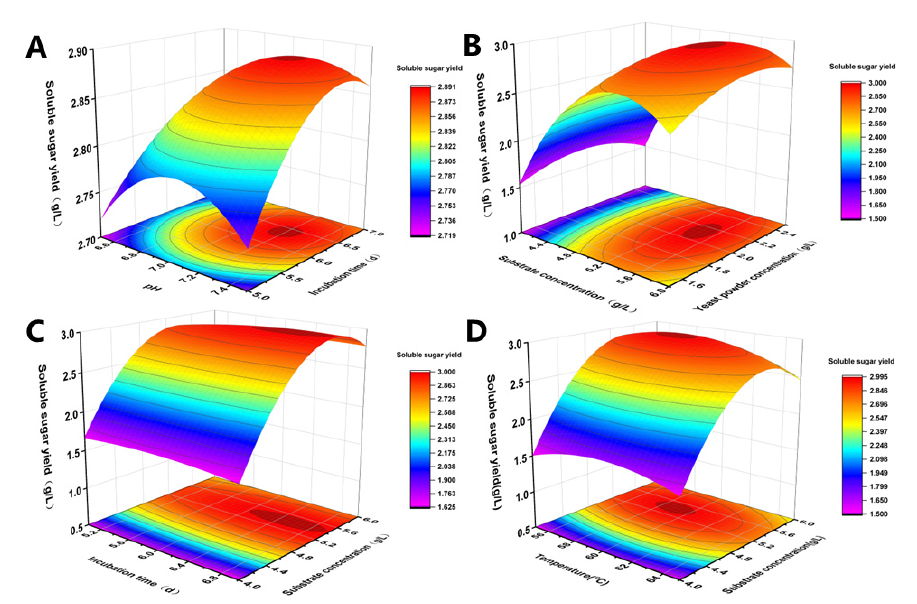
Figure 5. Surface results of effects on sugar production yield under different culture conditions: ( A ). Effect of pH and incubation time; ( B ). Effect of substrate concentration and yeast powder concentration; ( C ). Effect of incubation time and substrate concentration; ( D ). Effect of temperature and substrate